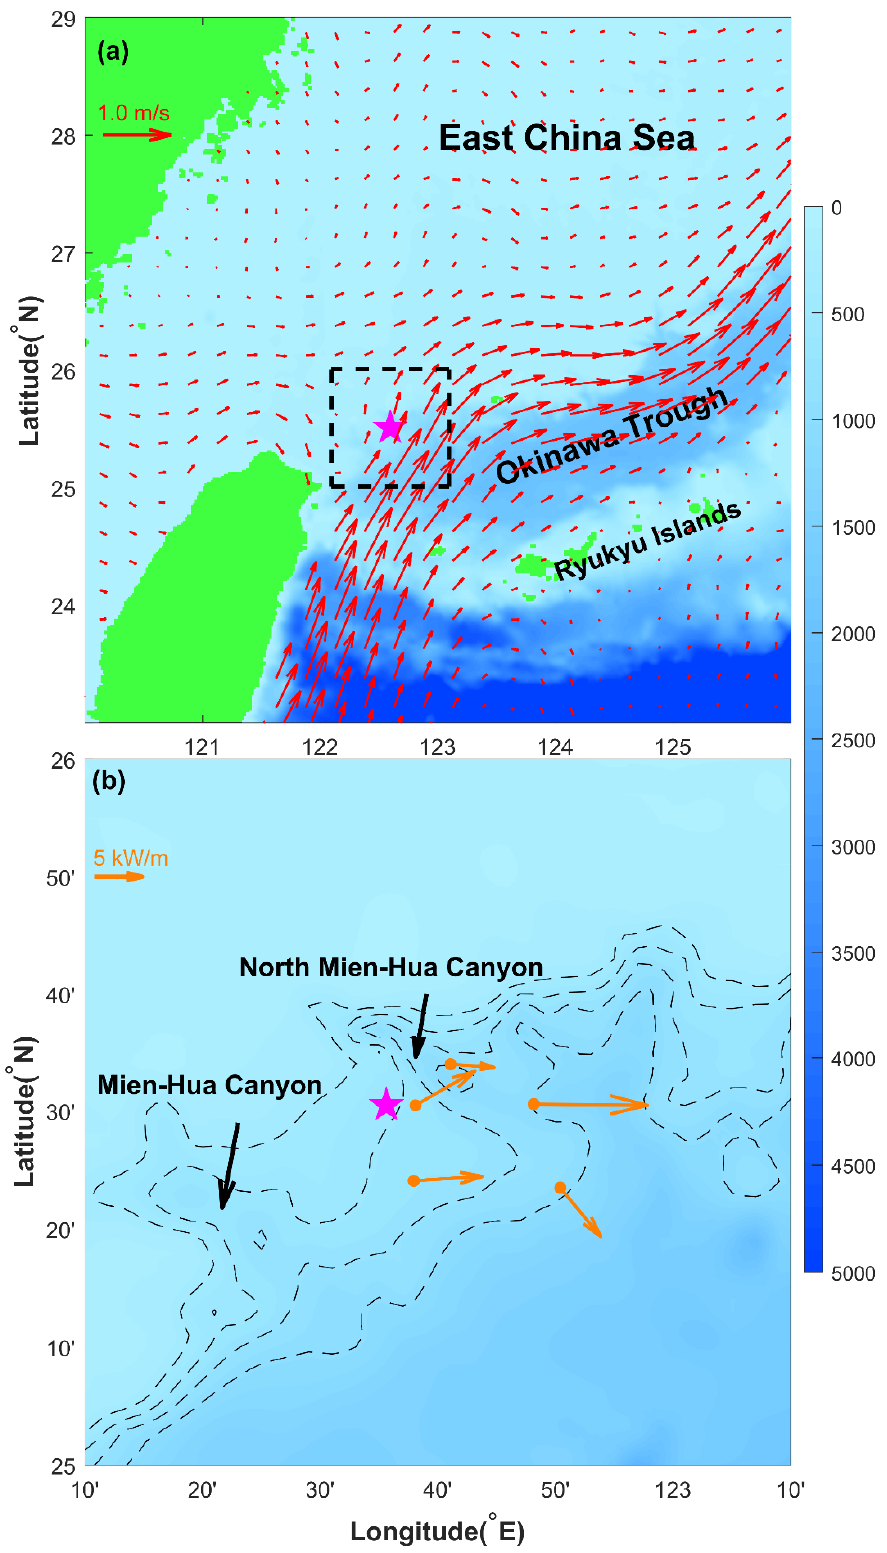
Figure 1. ( a ) Bathymetry of the southeastern East China Sea based on ETOPO-1 data. The red arrows denote the mean geostrophic current referenced to the period of 1993–2012 from the AVISO dataset. ( b ) Inset of the outlined square in ( a ) showing the location of the moored station (magenta pentagram) and the topography surrounding the moored station. The contours are 400 m, 600 m, 800 m, and 1000 m isobaths. The orange dots and arrows denote the observation stations and the observed